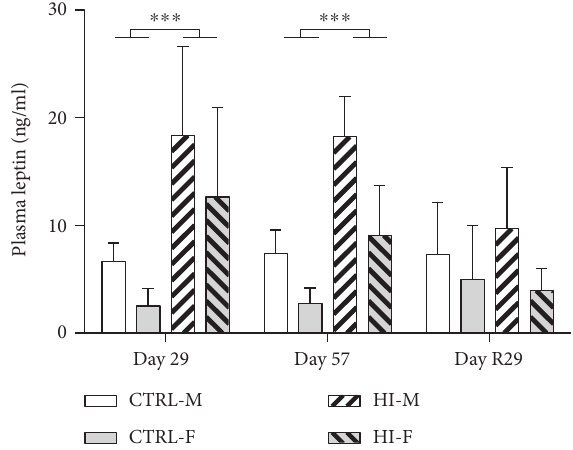
Figure 6: Plasma leptin levels, mean + SD. CTRL-M: n = 7 − 10 , HI- M: n = 4 − 8 , CTRL-F: n = 8 − 10 , and HI-F: n = 6 − 9 . At all three time points, males had signi fi cantly higher leptin levels compared to females ( p = 0 0325 , p < 0 0001 , and p = 0 0182 ). ∗∗∗ p < 0 001